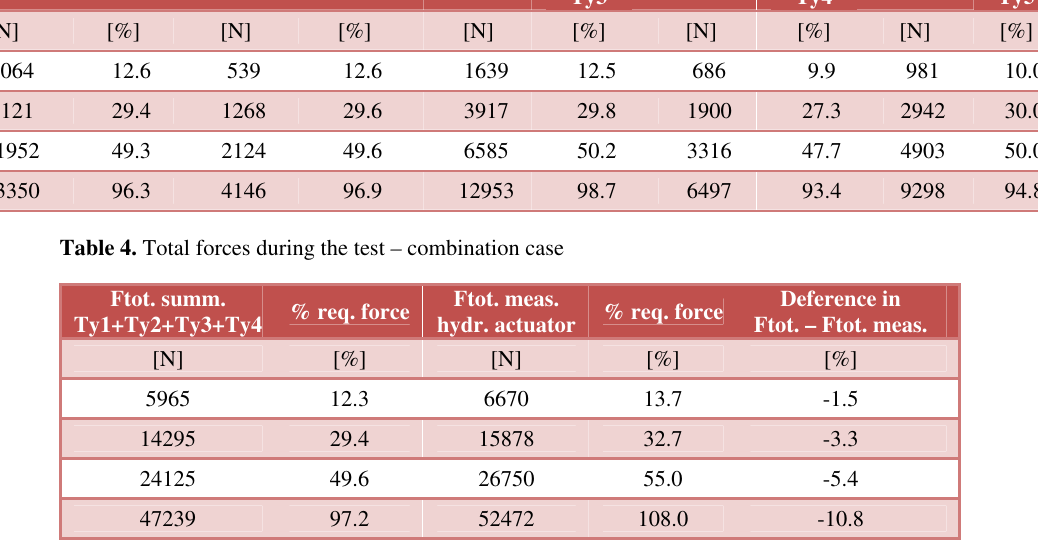
Table 3. Forces in the individual cuts during the test (required and really reached) – combination case % req. Ty1